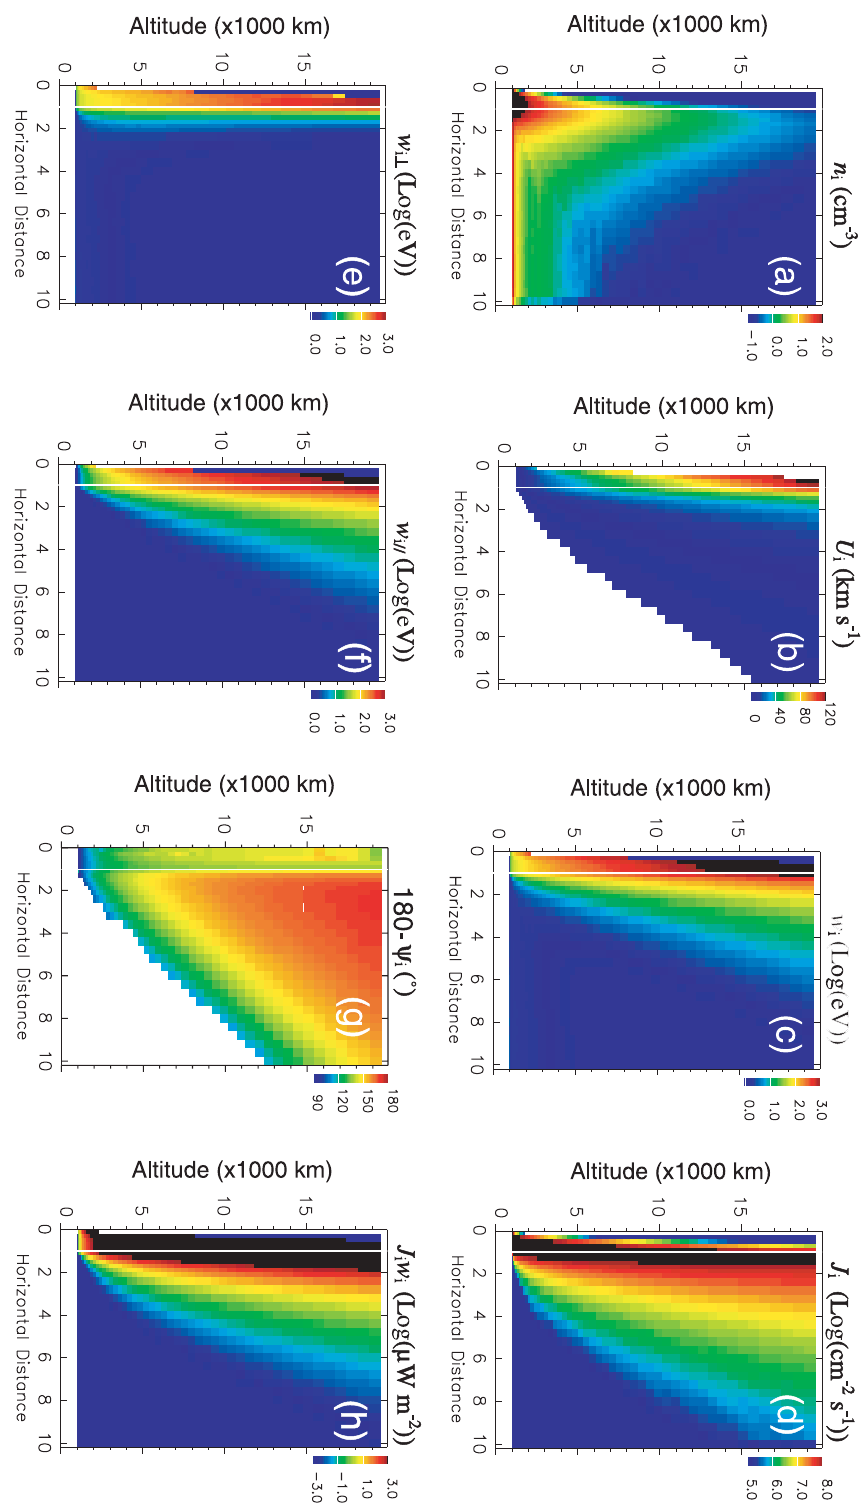
Fig. 2. Transport patterns of O + moments in the (X,s) plane : ( a ) density in cm − 3 for a value of 5000cm − 3 at the low-altitude boundary, ( b ) upward mean velocity in kms − 1 , ( c ) mean energy in eV, ( d ) fluence in Log(cm − 2 s − 1 ), ( e ) perpendicular mean energy in eV, ( f ) parallel mean energy in eV, ( g ) mean pitch angle in ◦ , and ( h ) energy density flux in Log( µ Wm − 2 ). The vertical white line corresponds to the poleward heating boundary ( X =